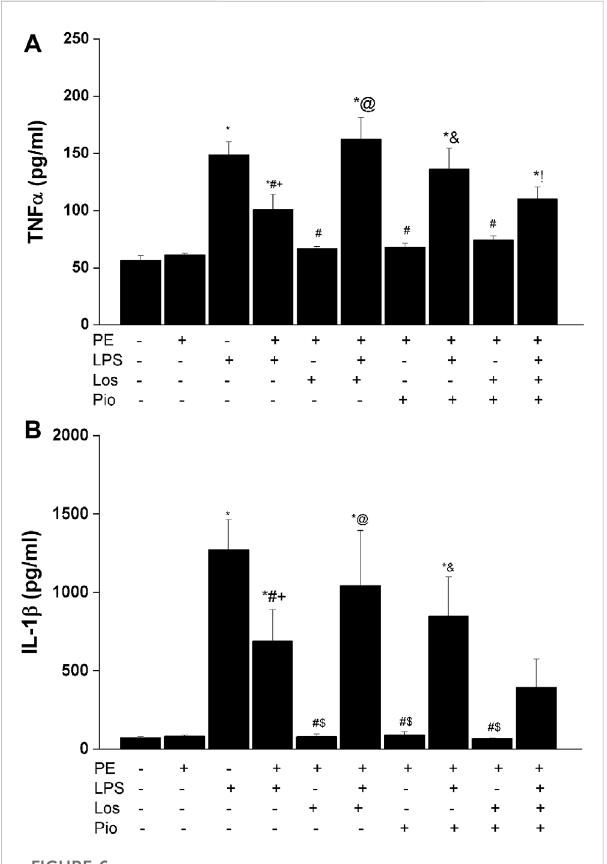
FIGURE 6 Effect of gestational losartan and/or pioglitazone therapy on serum levels of TNF- α (panel A )and IL-1 β (panel B )in male offspring of PE or PE/LPS dams. Data are expressed as the mean ± SEM. The One- way ANOVA followed by the Tukey ’ s post hoc was utilized to measure statistical signi fi cance. * p < 0.05 vs. “ Control ” , + p < 0.05 vs. “ PE ” , # p < 0.05vs. “ LPS ” , $ p < 0.05vs.PE/LPS, @ p < 0.05vs. “ PE,Los ” and & p < 0.05 vs. “ PE, Pio ” values.